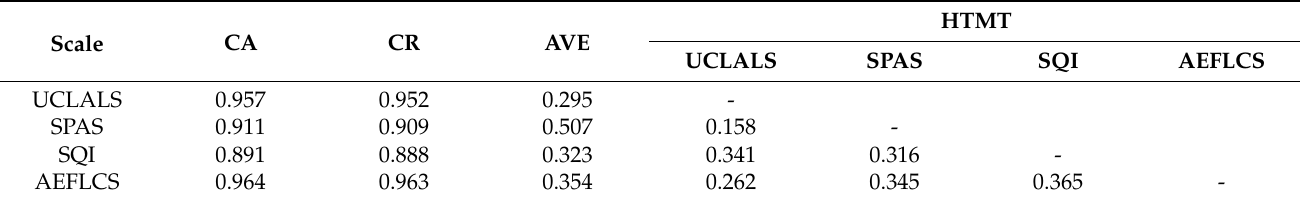
Table 2. Reliability and validity